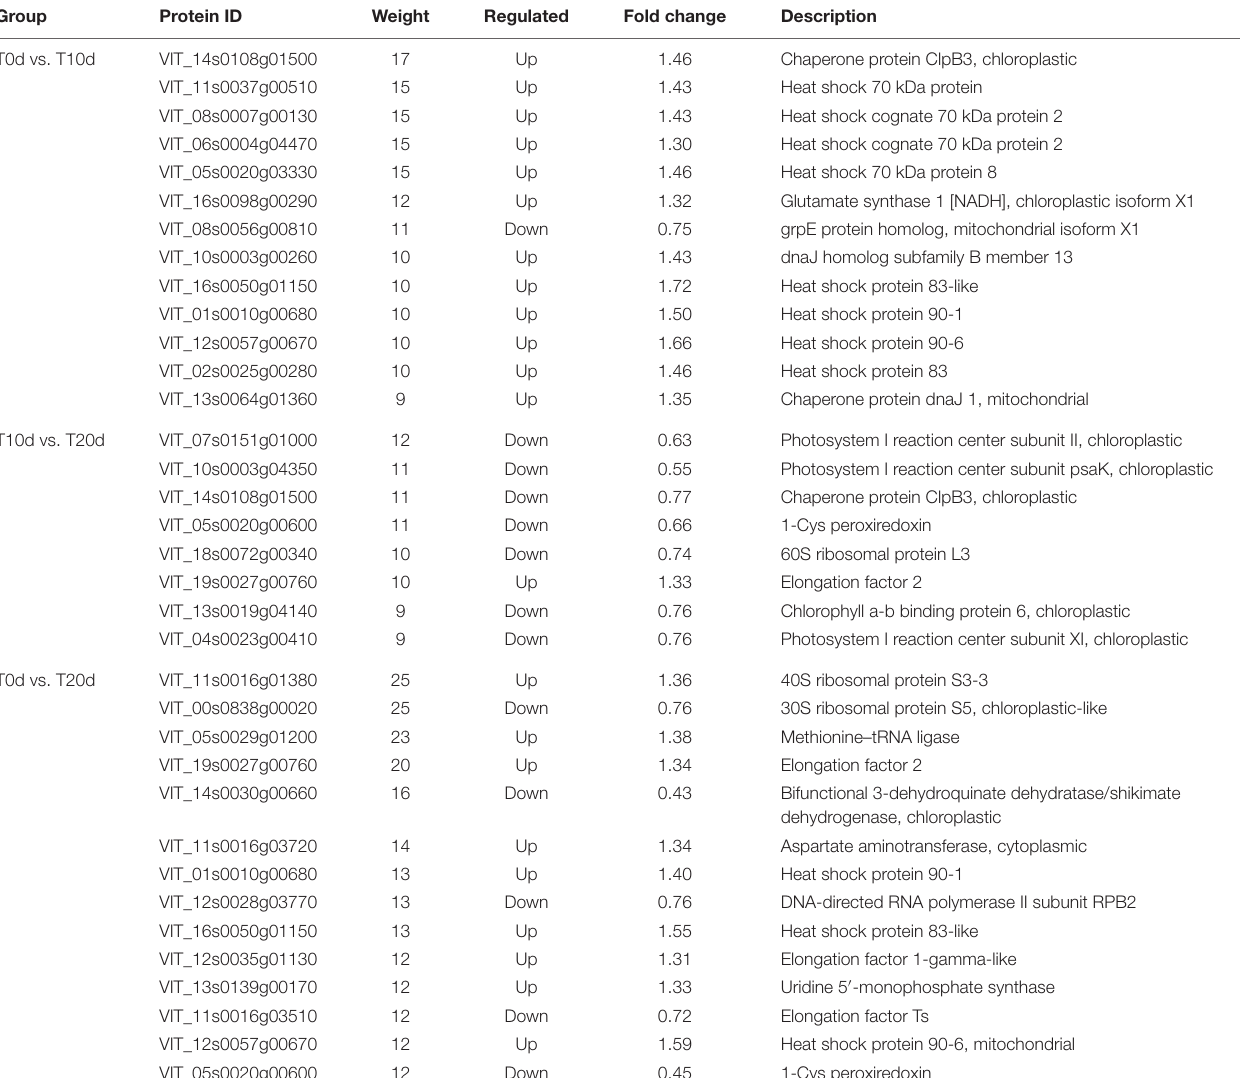
TABLE 2 | DEPs with high connectivity weight in the PPI analysis between groups. Group Protein ID Weight Regulated Fold change